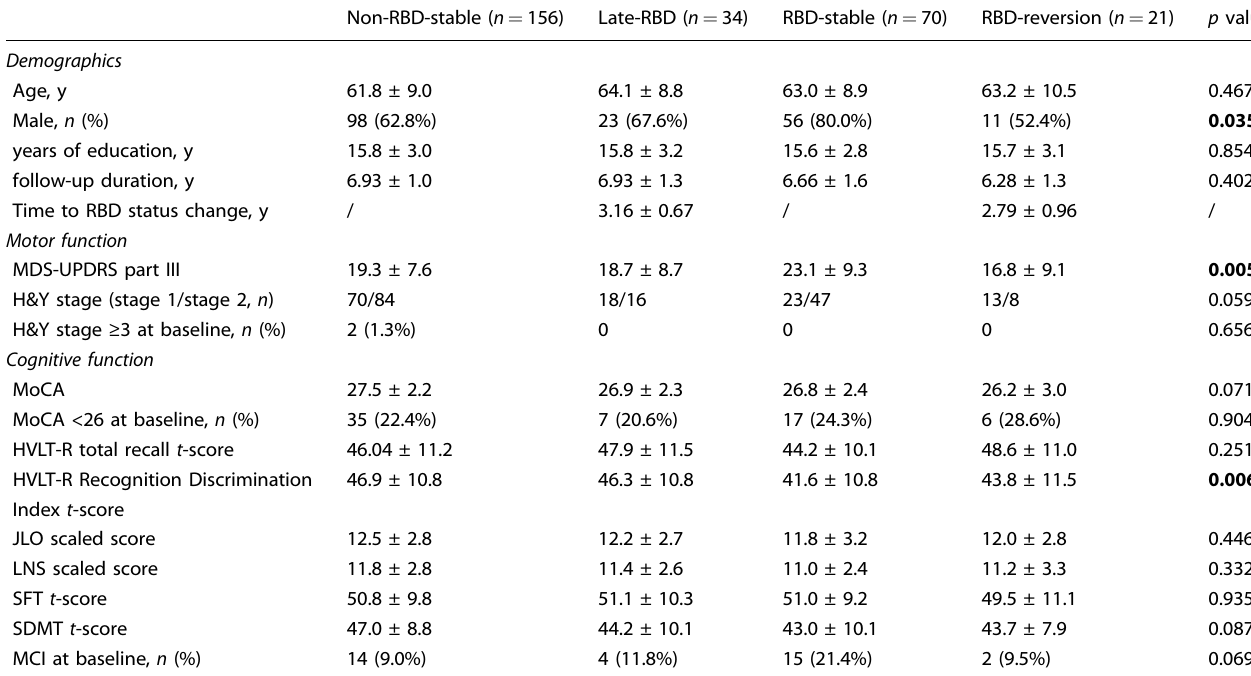
Table 1. Patient demographics and clinical characteristics at